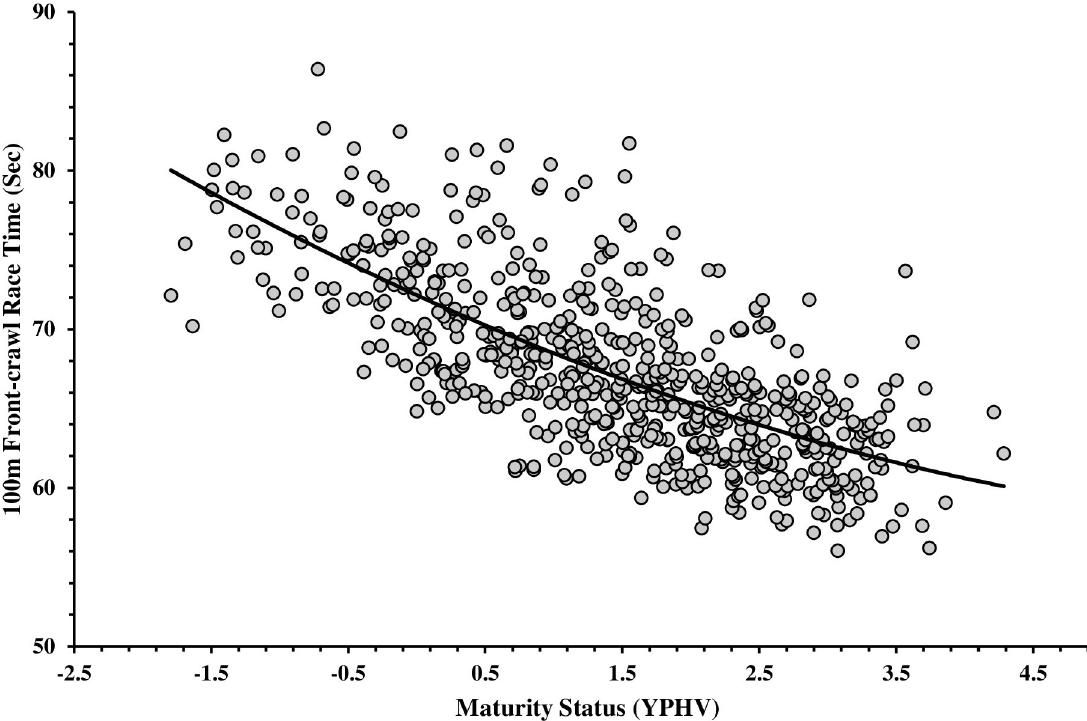
Fig 2. The curvilinear relationship between maturity status (YPHV) and 100-m FC performance time (sec) in females aged 10–15 years at regional-national level